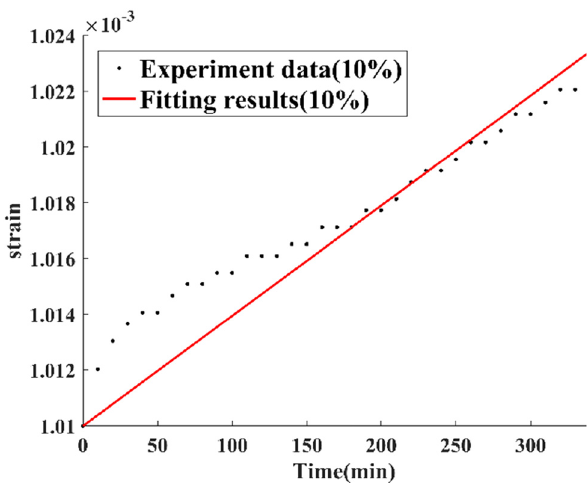
Figure 6: Fitting results based on the conventional Maxwell model and 10% stress level.